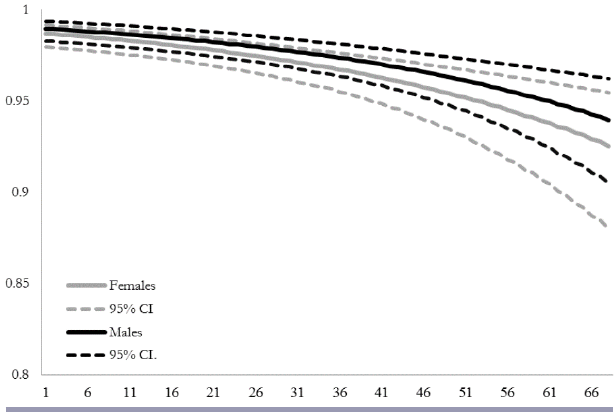
Fig. 2 . Survival probabilities of male and female Mountain Plover ( Charadrius montanus ) chicks based on data collected from 2010 to 2012 in eastern Colorado. Figure illustrates the relationship of survival probabilities between male and female chicks and day of hatching within the breeding season starting at day 1 (May 9) and continuing through day 68 (July